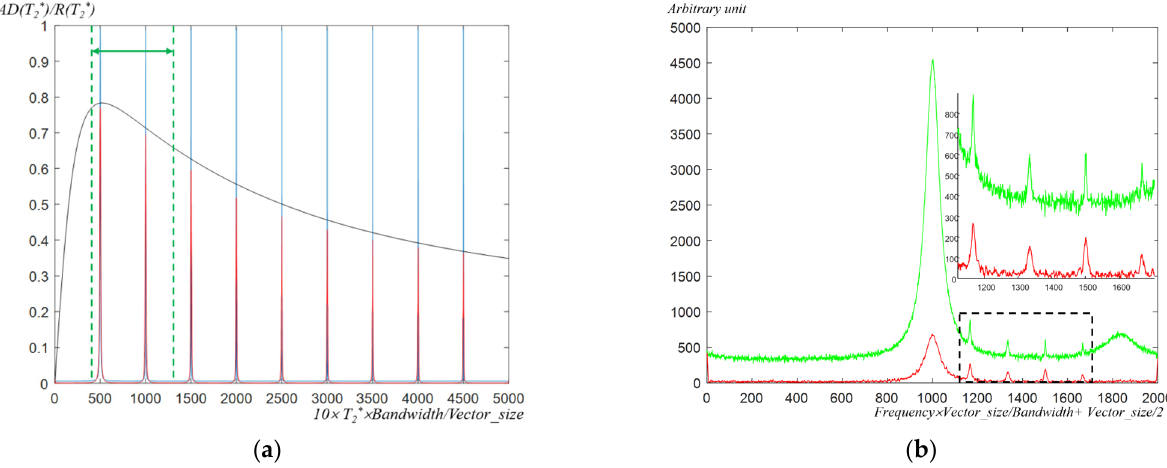
Figure 3. Results of T 2 * selectivity by the differential filtering of the simulation data: ( a ) graphs representing the T 2 * selectivity of the applied differential operators according to the T 2 * when the frequency is F at the spectral signal; spectral signal graphs of the blue line indicate the 9 kinds of the UFRV input signal according to the sequential different F and T 2 *; the black line that shows the ratio between the DFAV and UFRV indicates the expected spectral signal intensity of the output DFAV of each input signal (blue color) when f is F. Spectral signal graphs of the red line show the 9 kinds of the DFAV output signal according to the sequential different F and T 2 *; green dot lines indicate the selected T 2 *-band (40–130 ms); ( b ) spectral signal comparison for input simulation UFRV data (green) and output simulation DFAV data (red); the black dotted box in the graph is the expended view image of the frequency band that shows the metabolites of interest; DFAV, differential filtered absolute value; F, resonant frequency for the metabolite signal; UFRV, un-filtered real value.